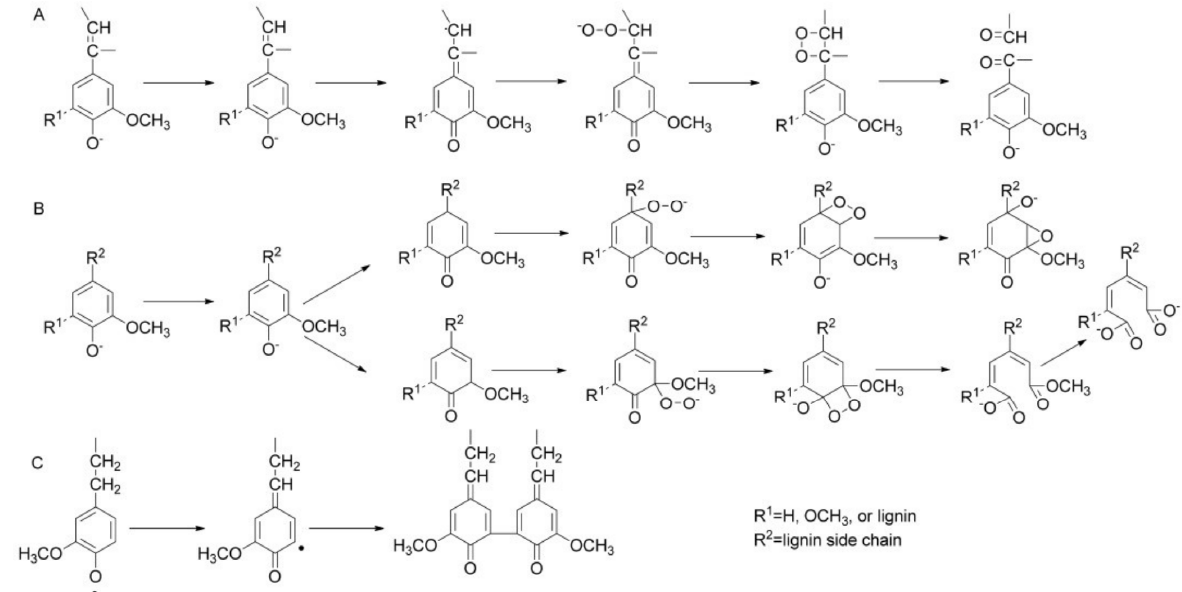
Figure 5. Oxygen oxidation of lignin mechanisms: ( A ) conjugated side-chain oxidation, ( B ) aromatic ring cleavage, and ( C ) oxidative condensation. (Reprinted from [42] Copyright 2015, with permission from John Wiley and Sons.)